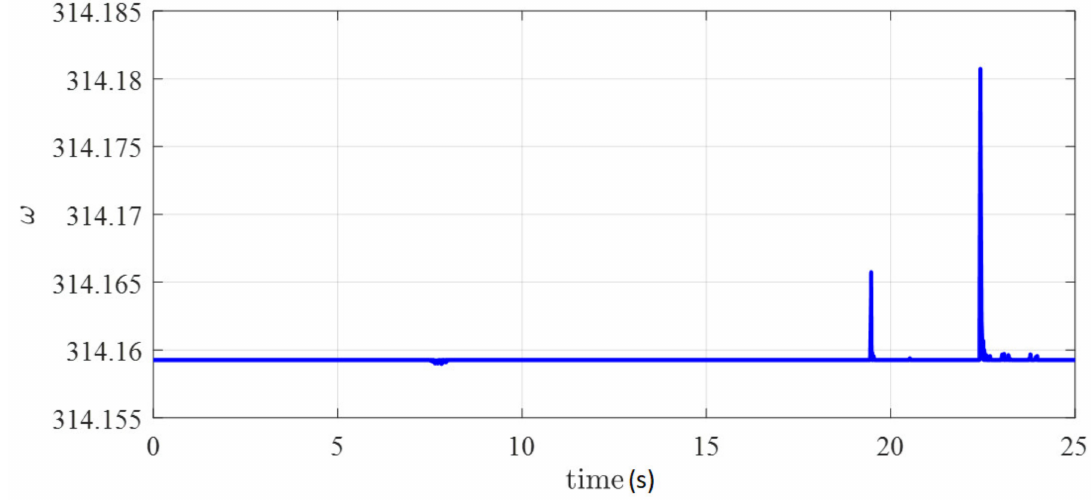
Figure 13. MPC output—angular frequency time